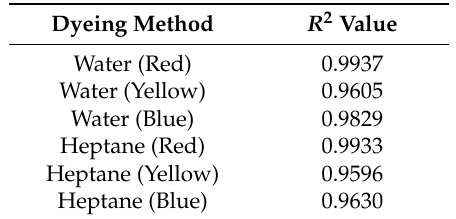
Table 5. The R -square value of the dyeing method of three primary colors.